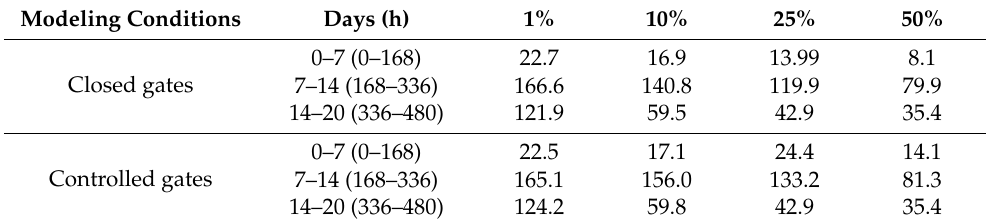
Figure 12. Distribution of flood duration during 10% exceedance probability flood hydrograph with closed gates ( a ) and operating gates ( b ). Table 4. Flooded areas with different inundation duration, sq. km . Table 4. Flooded areas with different inundation duration, sq. km.